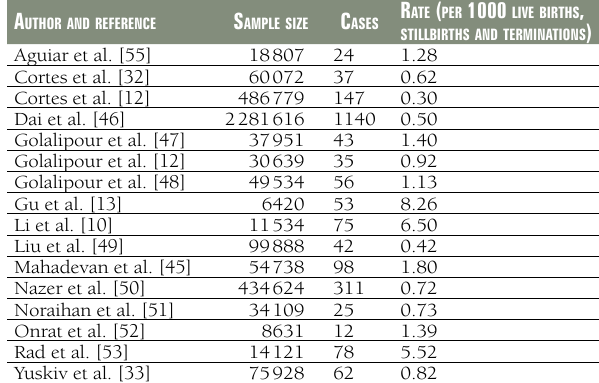
Table 10. Studies that reported rates for the burden of anencephaly based on live births, stillbirths and terminations of pregnancy a utHor aNd refereNCe s ample